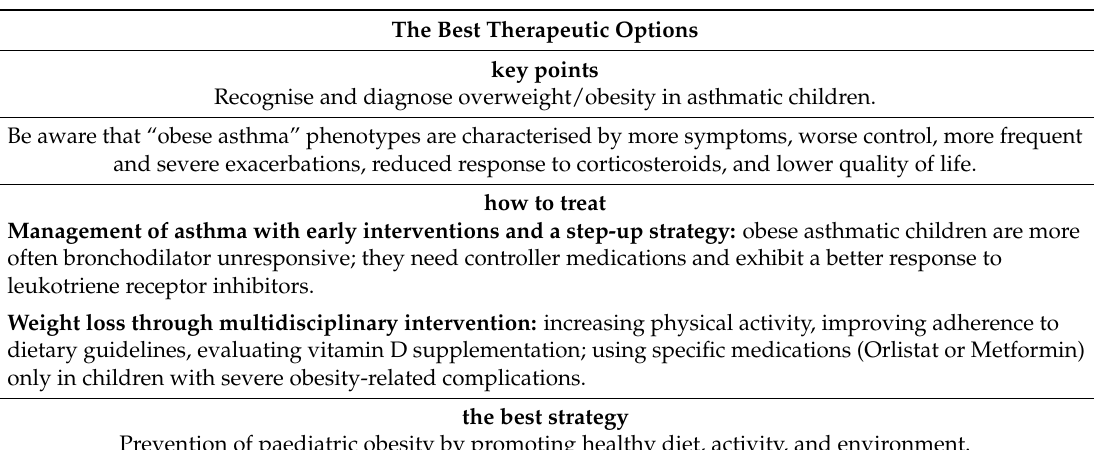
Table 2. The best therapeutic options in obese children with